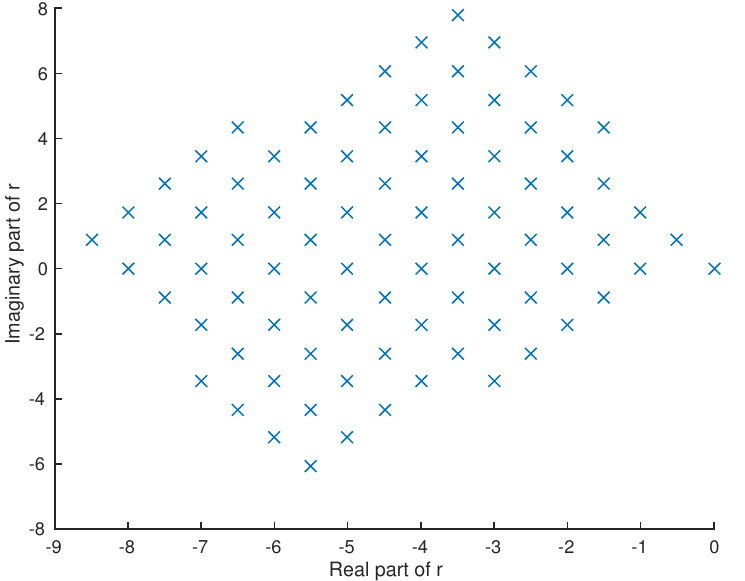
Figure 2. The remainders r of Euclidean division by b = 2 + 10 ω in Z [ ω ] . There are 2 2 − 2 · 10 + 10 2 = 84 = | b | 2 crosses, which can be all representatives of Z [ ω ] / (cid:104) b (cid:105) , satisfying (19). The case of R = Z p . For a , b ∈ R with b (cid:54) = 0, the results s , r of Euclidean division a = sb + r with ψ ( r ) < ψ ( b ) and ψ ( · ) = p ord ( · ) or ψ ( 0 ) = 0 are not unique because 3 = 0 · 2 + 3 = 1 · 2 + 1 for p = 2. Let Q p be the field of fractions of R . For c ∈ Q p , there exists w ∈ Z such that c = ∑ ∞ c h p h ∈ Q p , we uniquely define { c } p = ∑ with c h ∈ { 0, 1, . . . , p − 1 } . For c = ∑ h = w